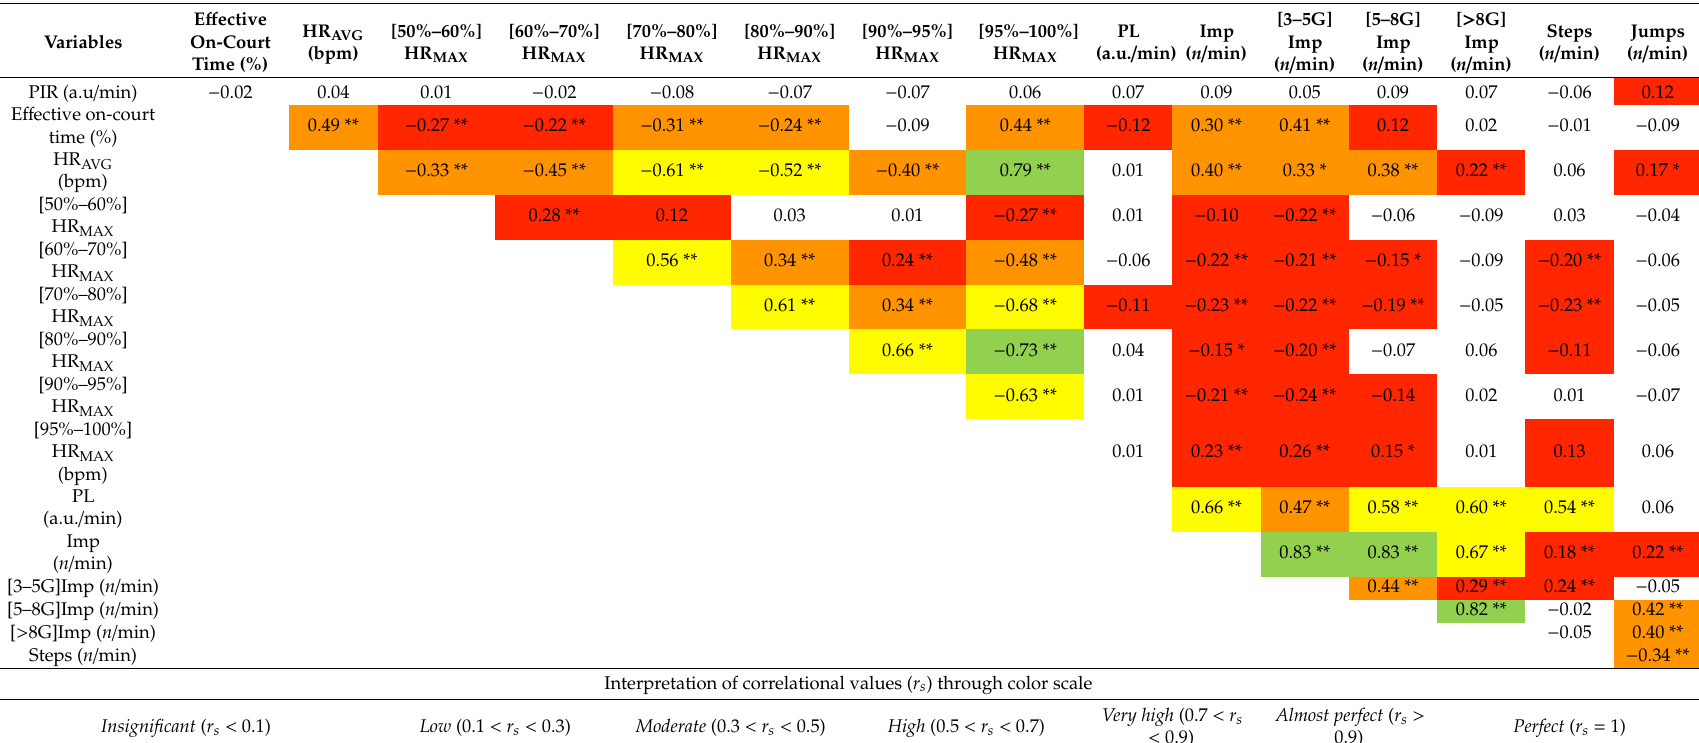
Table 5. Correlational analysis of the physical and technical variables registered in the present